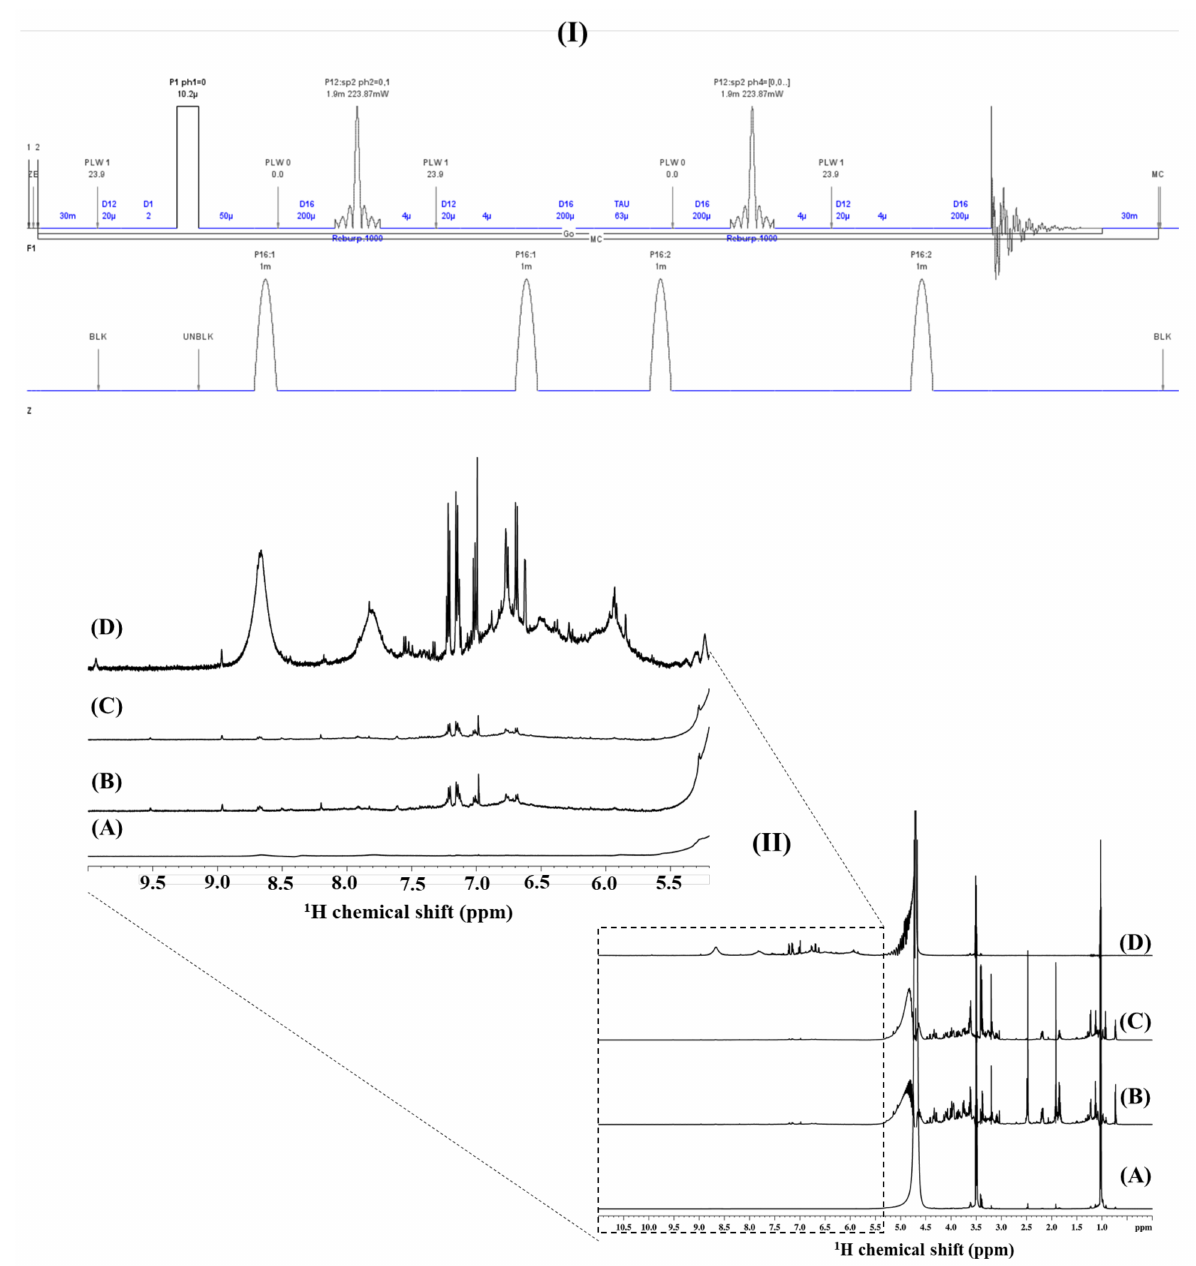
Figure 2. Sensitivity enhancement was obtained in wine samples with a double pulsed-field-gradient echo (DPFGE) proton NMR experiment ((I) and spectrum ( II, D ) with respect to a standard q- 1 H- NMR direct polarization experiment ( II, A ). A { 1 H water_presat NMR}-1D single-pulse NOESY spectrum with an off-resonance shaped-pulse for water and ethanol multi-presaturation during both the relaxation delay and mixing times ( II, B ) [33] and a { 1 H water_presat NMR} spectrum with identical conditions as in ( II, B ) but with an additional continuous-wave decoupling module to eliminate the intense 13 C satellites of the ethanol signals ( II, C